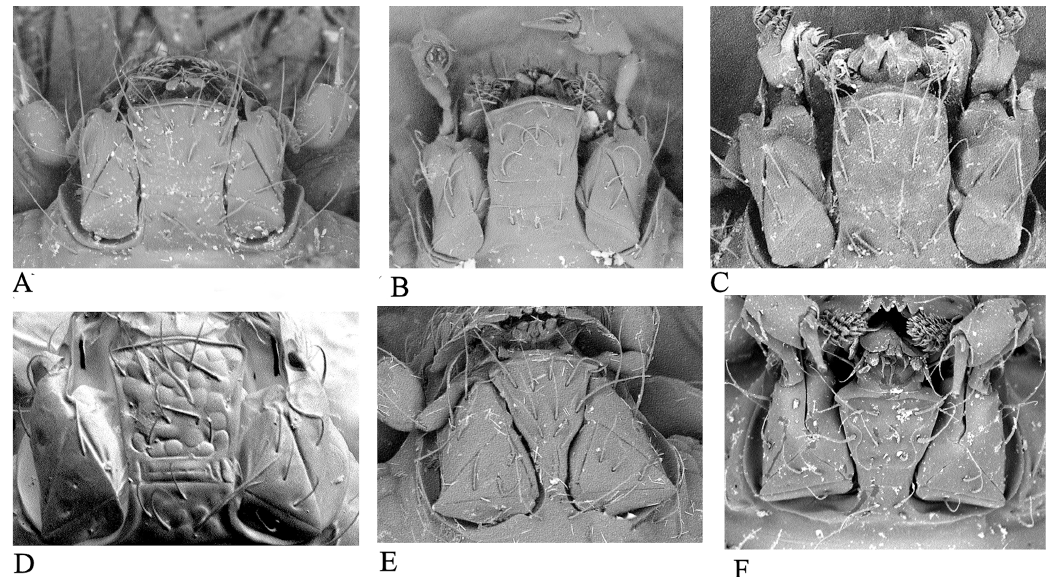
Fig. 4. Menta and submenta. A . Cissidium petri Darby, 2015, × 1380. B . Cissidium tigrum Darby, 2015, × 1220. C . Cissidium amboroense Darby, 2015, × 1260. D . Cissidium losbanos sp. nov., × 1100. E . Cissidium triangulum Darby, 2019, × 650. F . Cissidium pilosellum sp. nov., ×